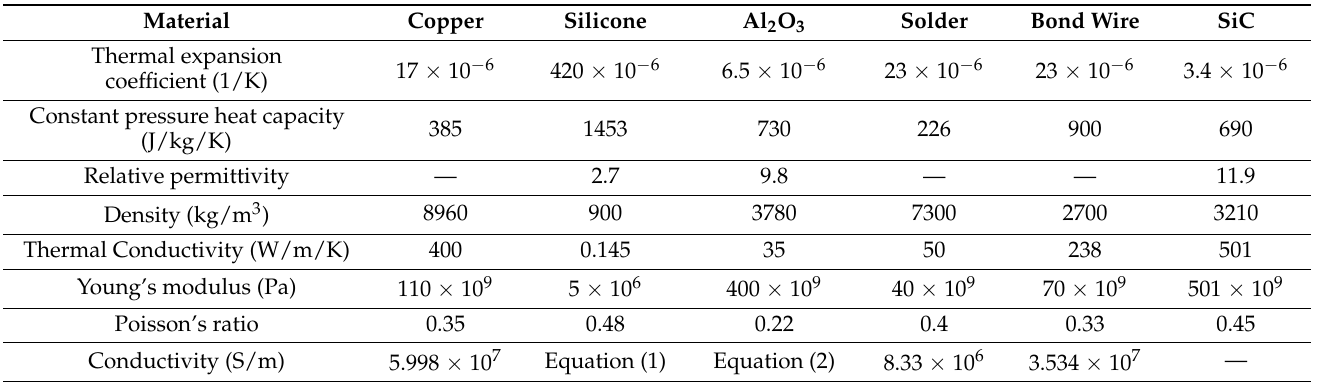
Table 1. Main parameters of selected materials for multi-physics